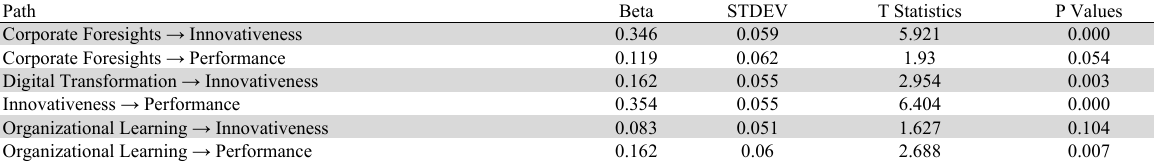
Fig. 1. Measurement Model (PLS Algorithm)